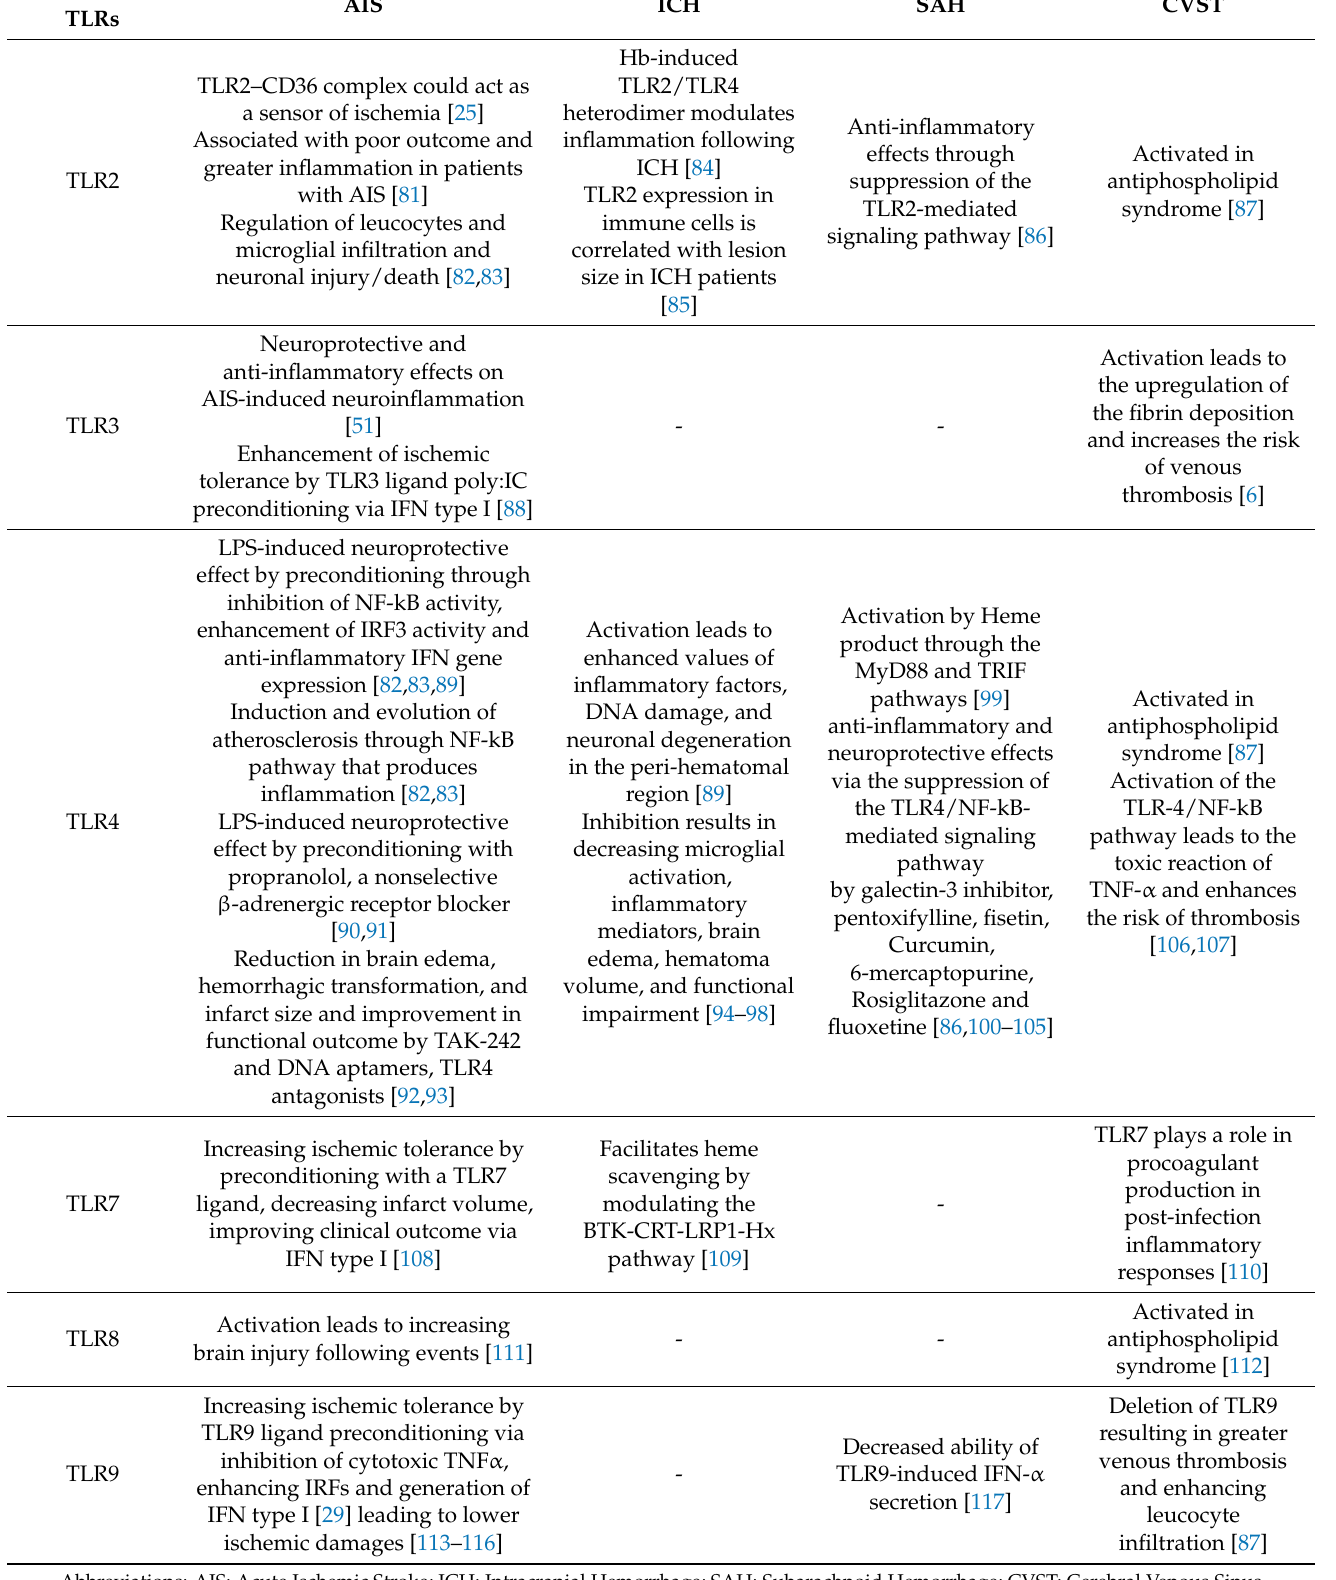
Table 1. A summary of the implications of various Toll-like receptors (TLRs) in different cerebral vascular diseases (CVDs).